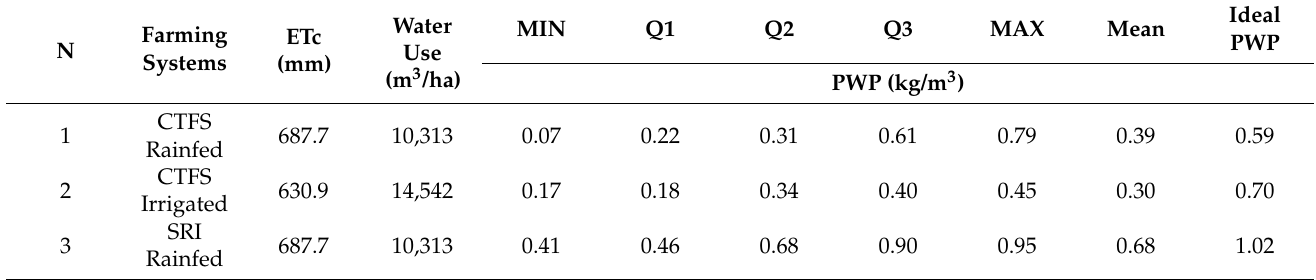
Table 3. Descriptive statistics for physical water productivity (PWP) in all farming